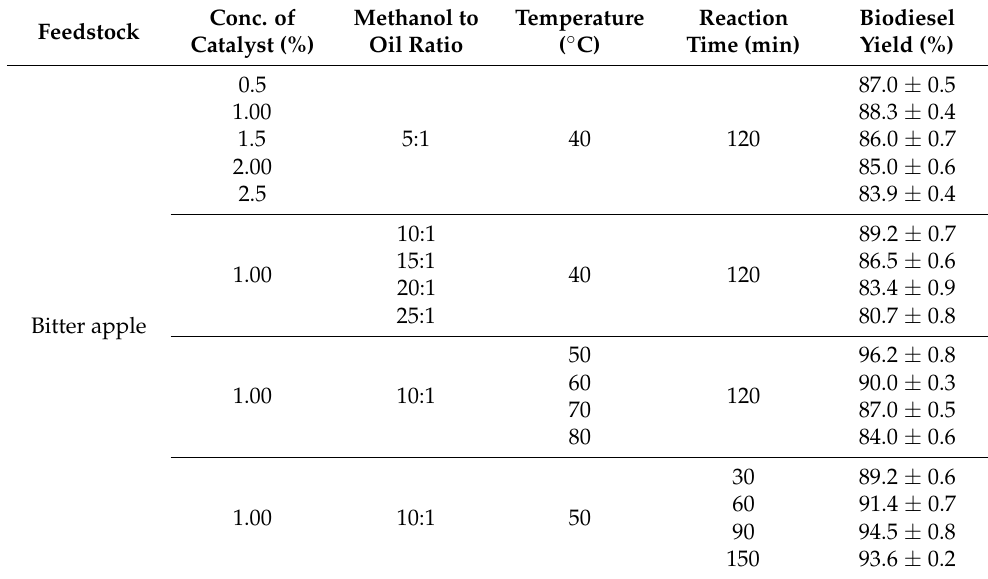
Table 6. Yield of biodiesel from bitter apple oil with changes in reaction parameters. Conc. of Methanol to Feedstock Catalyst (%) Oil